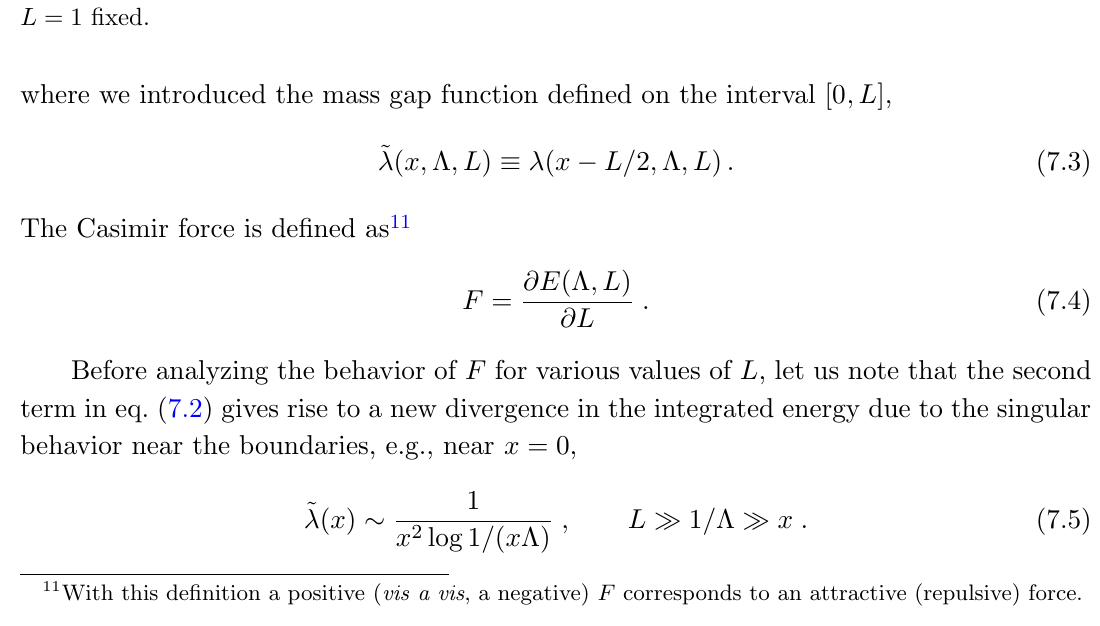
Figure 8 . The total energy density at the mid- point, E , is plotted against (cid:3) for L = 1